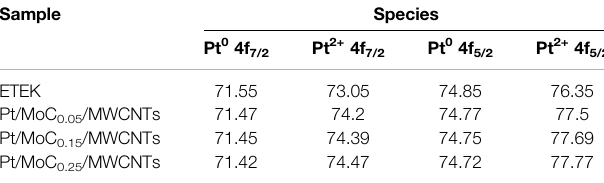
TABLE2| BindingenergiesofXPSspectraofPtinETEKandPt/MoC x /MWCNTs.